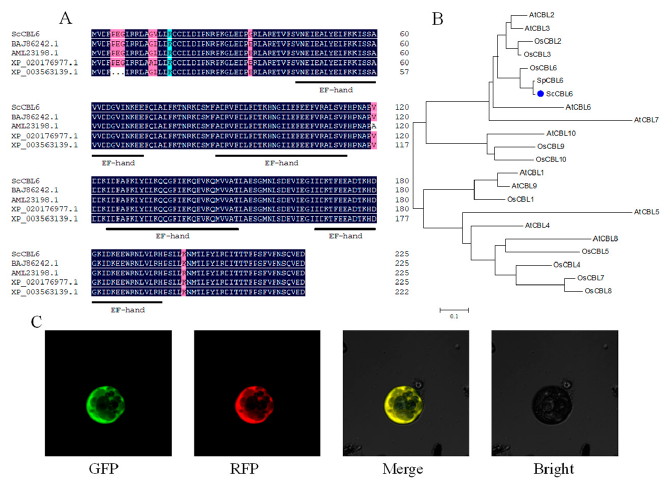
Figure 1. Biological properties of ScCBL6 . ( A ) Amino acid sequence alignment of the CBL6 protein from Stipa capillacea (ScCBL6), Hordeum vulgare subsp. vulgare (BAJ86242.1), S. purpurea (AML23198.1), Aegilops tauschii subsp. tauschii (XP_020176977.1), and Brachypodium distachyon (XP_003563139.1). Cyan and pink indicated bases with an identity higher than 75% and 50%, respec- tively. ( B ) Phylogenetic analysis of ScCBL6, SpCBL6, and CBL family members in Arabidopsis thali- ana and Oryza sativa . Blue dot signifies the gene of interest. ( C ) Subcellular localization of ScCBL6. Green fluorescent protein (GFP) excited at 488 nm captured using an Olympus FV1000 laser confo- cal microscope; red fluorescence (RFP; excited at 583 nm) indicating the tonoplast marker, which was the same as the plasmid (vac-rb CD3-976) in a previous study [30]; Merge, overlapping GFP and RFP; Bright, bright field. 3.2. ScCBL6-Overexpressing Arabidopsis Demonstrated Enhanced Cold Tolerance To explore the biological function of ScCBL6 in vivo, we generated transgenic Arabidopsis carrying ScCBL6 downstream of the CaMV-35S promoter. Three independent transgenic lines were obtained by gene-specific polymerase chain reaction (PCR; Figure S2). Under natural greenhouse conditions, ScCBL6-overexpressing plants (ScCBL6-OXP) and wild-type (WT) Ar- abidopsis did not show a significant difference in growth. Similar results were obtained under drought stress, as revealed by the survival rate and Fv/Fm (Figure 2). Under freezing condi- tions, ScCBL6-OXP outgrew the WT in terms of survival rate and Fv/Fm. In the subsequent recovery process of cold-treated plants, the WT perished owing to regeneration loss, while ScCBL6-OXP gradually regained normal growth, indicating its higher tolerance to cold stress than that of the WT (Figure 2). The water loss rate of detached leaves did not differ signifi- cantly between ScCBL6-OXP and the WT (Figure 3).